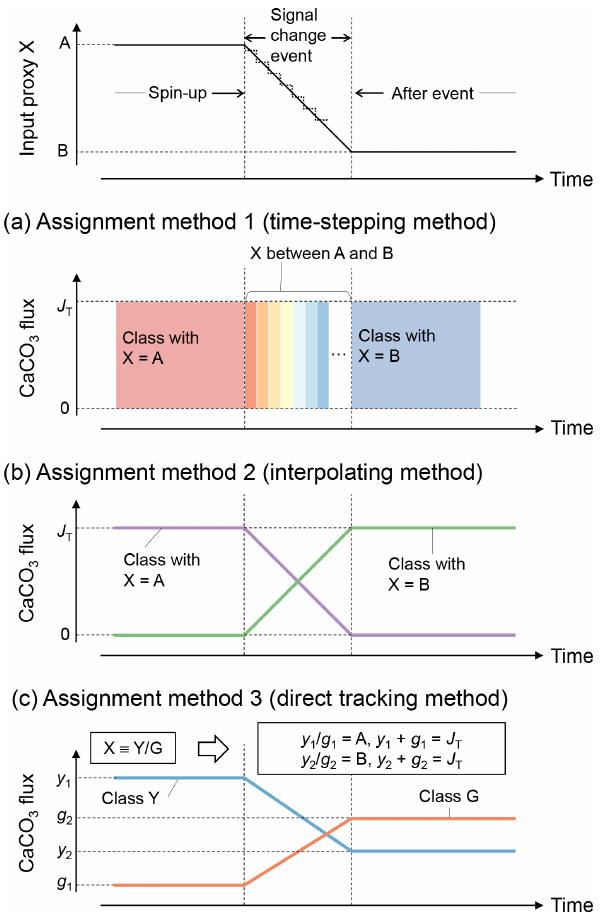
Figure 5. Schematic of the sediment column for signal tracking. The left side of diagram shows the sediment calculation domain that can be divided into mixed and historical layers. Signals are bio-mixed or lost by dissolution in the mixed layer and deteriorated at deep depths in the historical layer by numerical diffusion. The right side of diagram shows the sediment column for signal track- ing which is composed of sediment layers that used to be located just below the mixed layer in the calculation domain and preserve proxy signals relatively well. Sediment depth in the latter system is denoted as “diagnosed depth” which can be calculated by the equa- tion in the diagram or Eq.